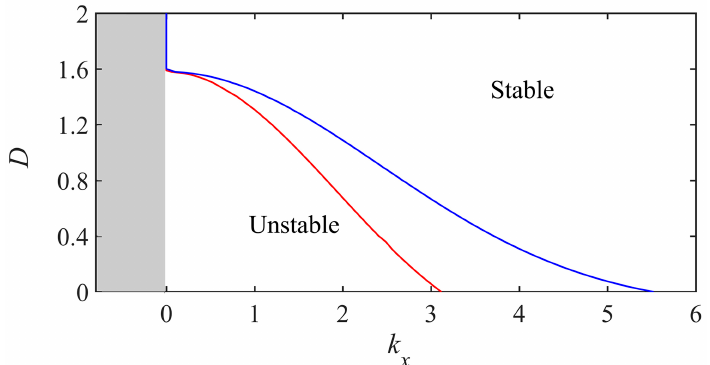
Figure 4. Marginal stability conditions in the plane ( k x , D ) (blue line). Red line represents the location of the relative maximum of the growth rate Re max ( ω )